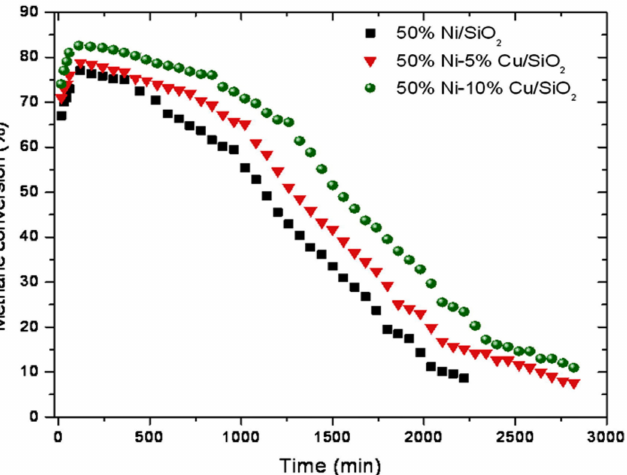
Figure 7. Catalytic performance of various Ni-Cu/SiO 2 catalysts at 750 ◦ C; reprinted with permission from ref. [79]. Copyright 2013